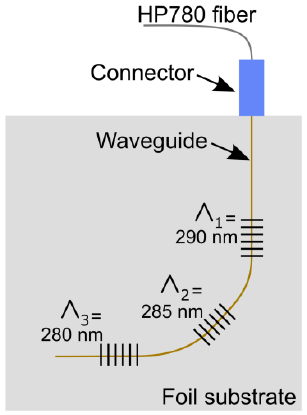
Figure 1. Layout of the strain sensor rosette showing the orientation of the grating sensors and the waveguide running perpendicularly over the gratings.